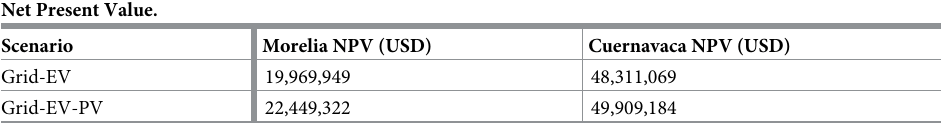
The economic evaluation indicates that electric mobility in the two cities case study is viable for the two analyzed